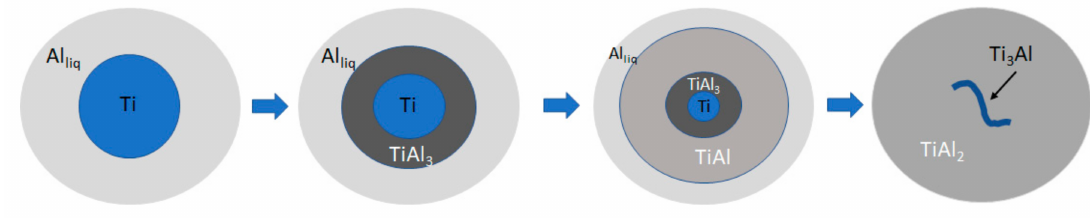
Figure 5. The generalized mechanism for the phase formation during SLM of reactive composite